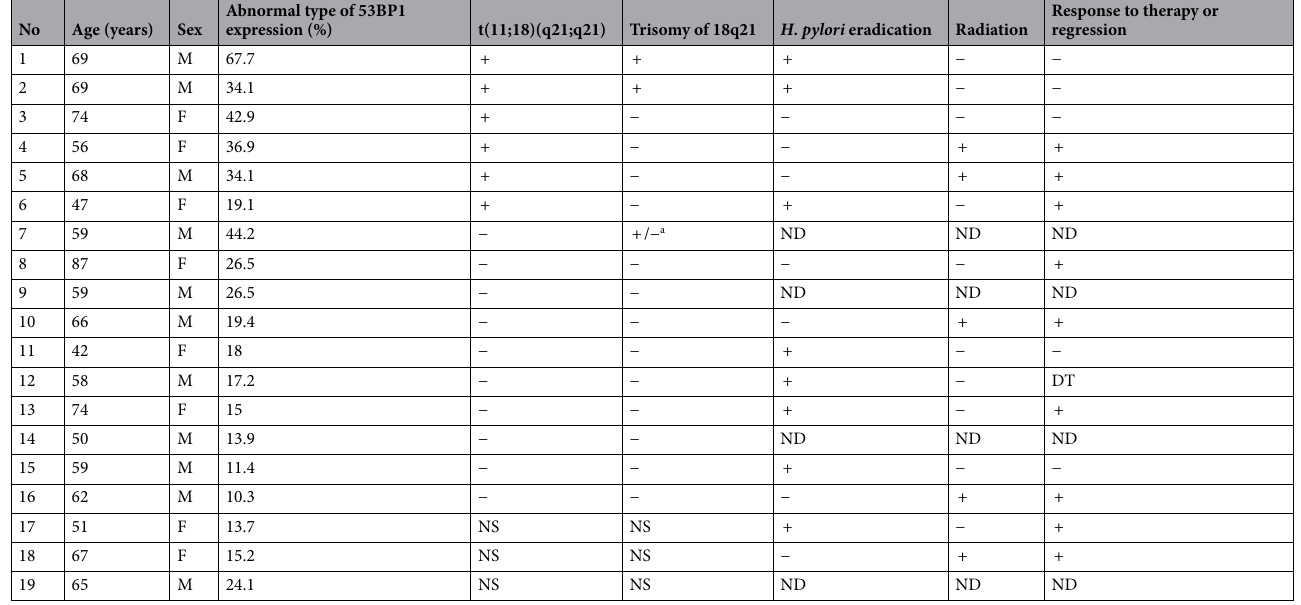
Table 4. Results of molecular analyses and response to therapy in MALT lymphomas. NS no signals, ND no data, DT during therapy. a Nuclei with trisomy <